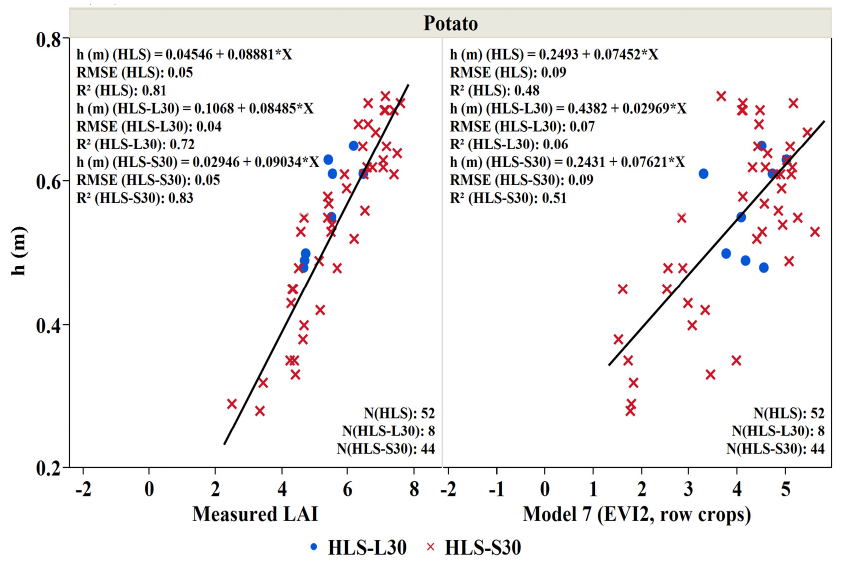
Figure 10 . Crop height (h (m)) as a function of measured LAI (m 2 /m 2 ) and LAI derived from Model 7 (EVI2, row crops) for potato crop studied during the 2019 growing season. Blue points represent the measurements during Landsat overpass and the red crosses represent the measurements during Sentinel 2 overpass.